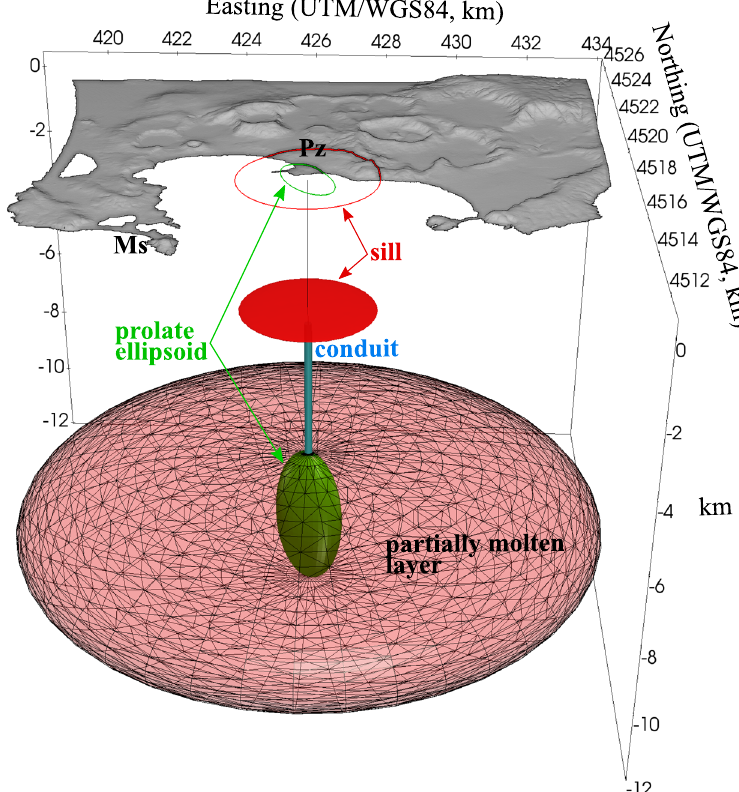
Figure 3. Schematized magmatic system of Campi Flegrei caldera. Sources reconstructed from surface deformation data in the last ~700